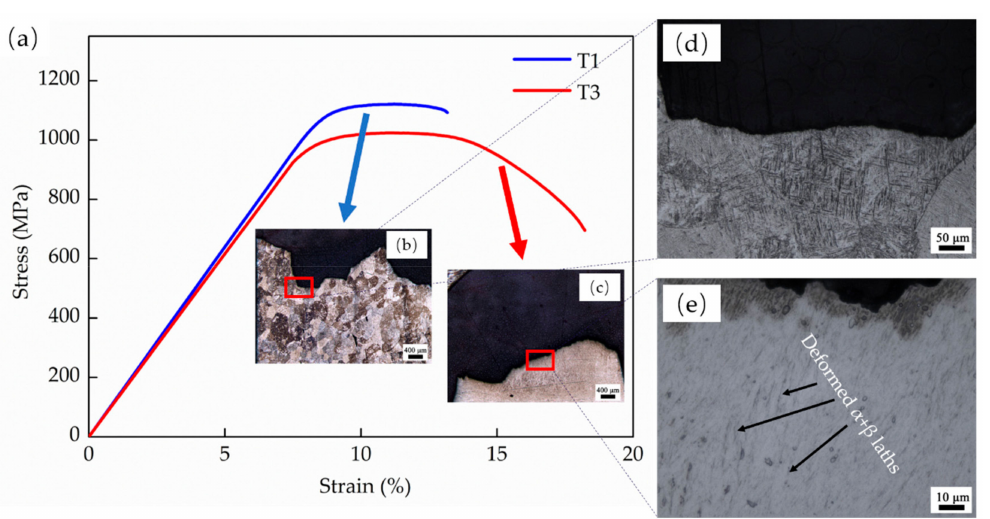
Figure 17. The tensile curves of T1 and T3 and the corresponding cross-sectional metallographic structure of fracture: ( a ) the strain-stress curves; ( b,d ) the metallographic structure of T1, and ( c,e ) the metallographic structure of